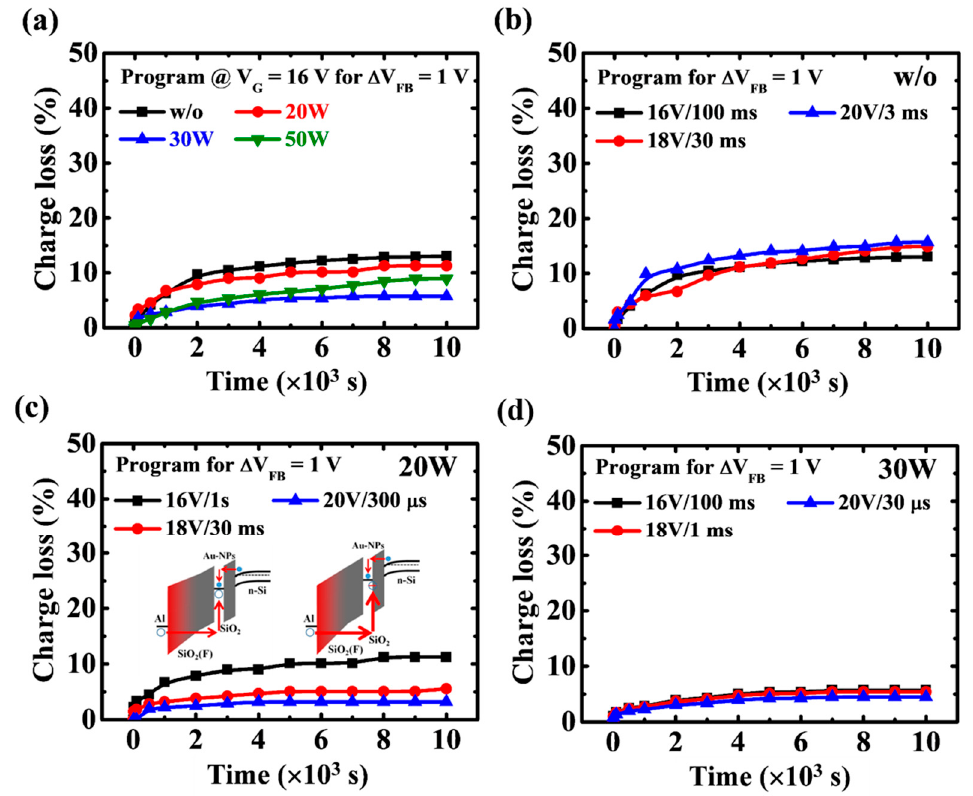
Figure 6. ( a ) Data retention characteristics of the Au-NP NVMs with low-damage CF 4 plasma treatment on the BO layer. The data retention properties at different programming voltages of the w/o, 20 W, and 30 W samples are shown in ( b ), ( c ) and ( d ), respectively. Schematic energy band diagrams of the 20 W sample at low and high programming voltages were illustrated in the inset figure of ( c ).